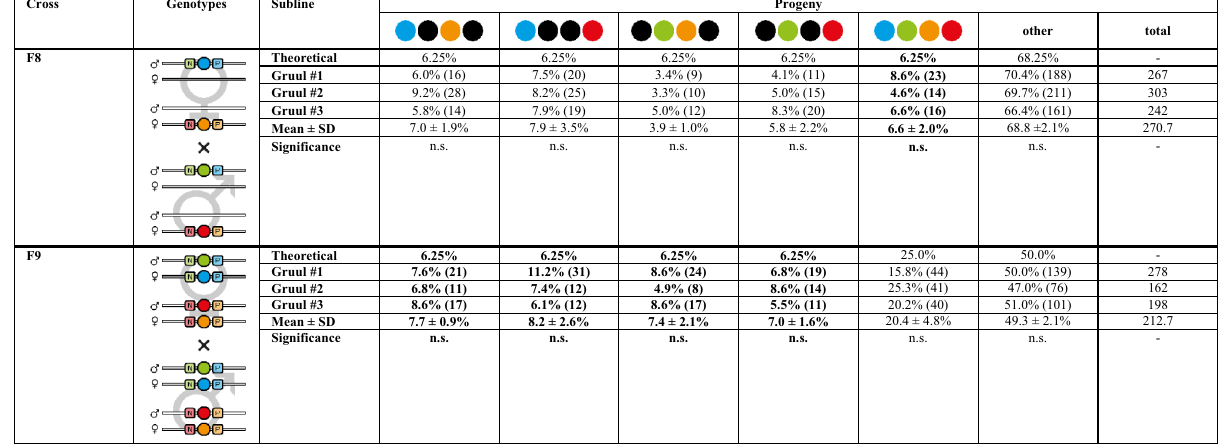
Table 1. Mating procedure results for the Gruul #1 to #3 hybrid sublines from the F8 to the F10 generation. Both F7 crosses (cf. Figure 1) resulted in 100% F8 (mO; mCe) and 100% F8 (mC; mVe) double hemizygotes, respectively. Progeny that were used in the subsequent crosses or to establish the F10+ continuative cultures are marked bold. The numbers in brackets and in the ‘total’ sub-column indicate the number of scored individuals. One-sample/two-tailed Student’s t-tests revealed no significant differences (n.s.) between the arithmetic means and the theoretical Mendelian